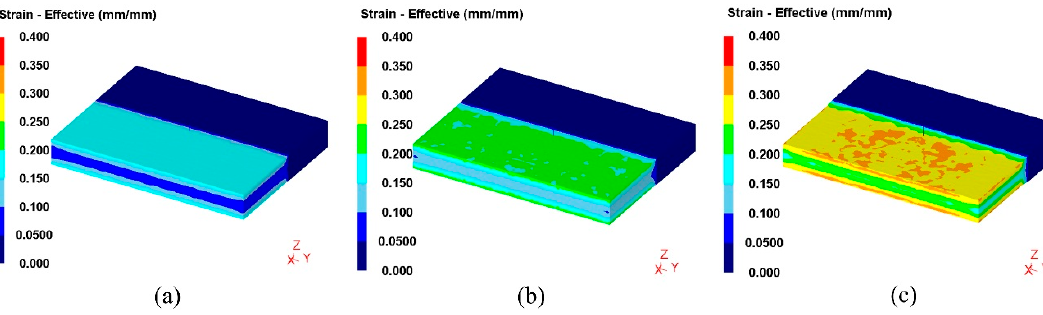
Figure 7. Distributions of effective strain after the HHR 2 process with different reduction amounts: ( a ) 20 mm; ( b ) 30 mm; ( c ) 50 mm.